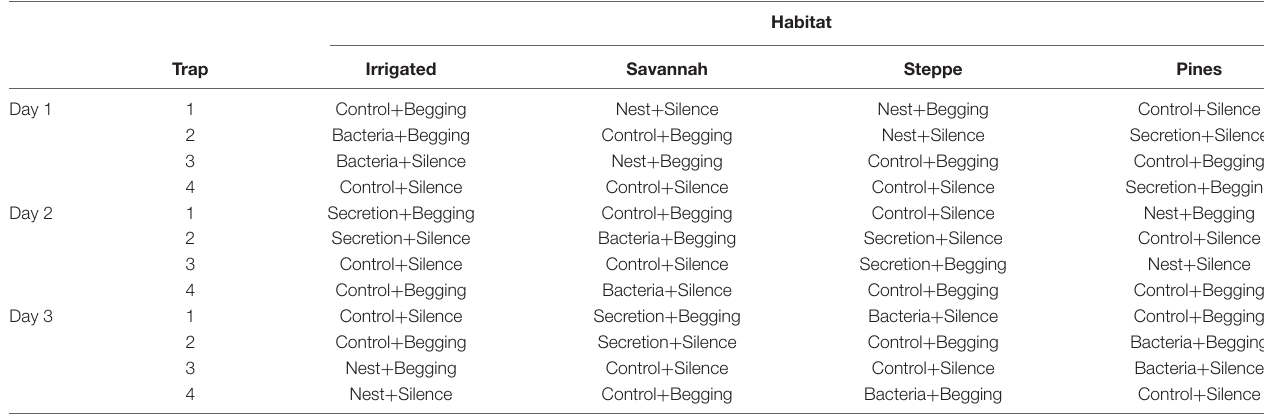
TABLE 1 | Assignment of hoopoe stimuli (chemical + auditory) to traps for capturing blood-feeding flies in relation to day of sampling and habitat in Guadix, south eastern Spain. Habitat Trap Irrigated Savannah Steppe Pines